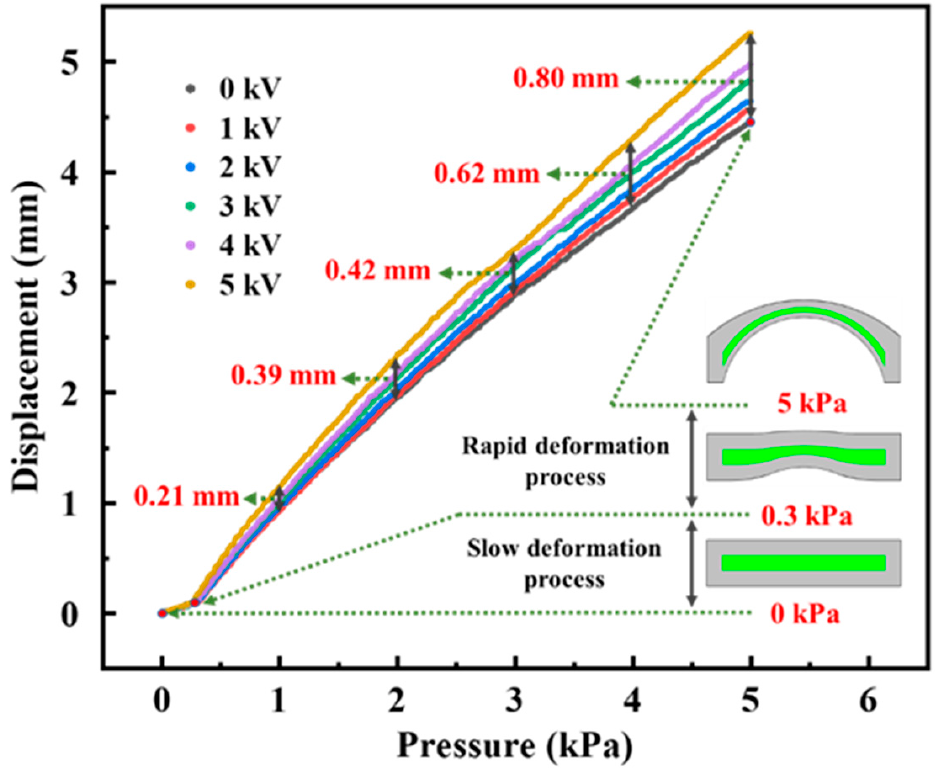
Figure 6. The output displacements of the SEHPA under different pressures and voltages.